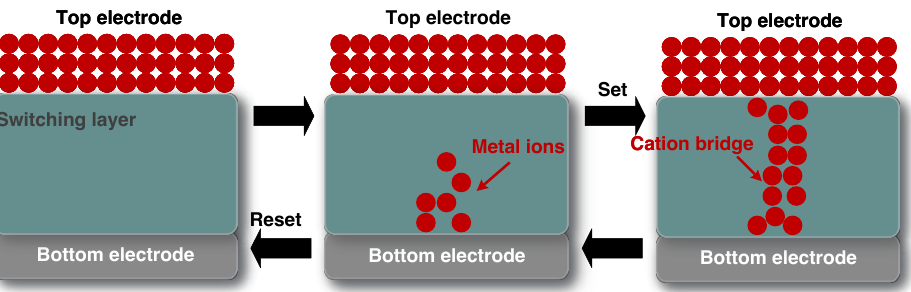
Figure 5. A ReRAM structure and its Set and Reset